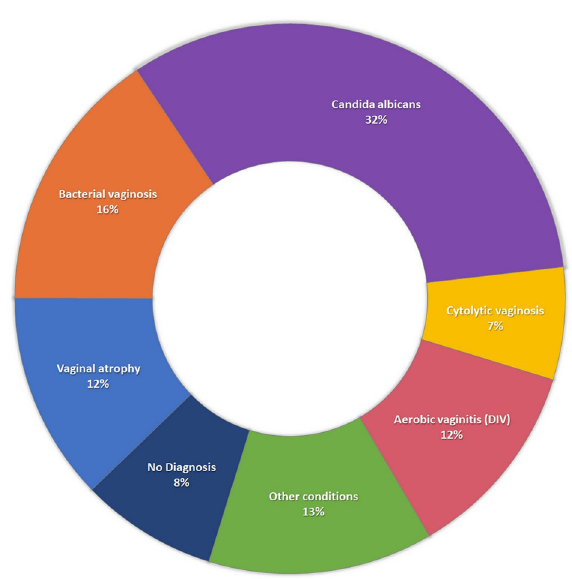
Fig. 2 The percent of cases by condition. Every diagnosed condition was separately counted. Re fl ecting 195 diagnosed conditions/192 patients including 22 cases of coinfection and 17 cases of no established diagnosis.